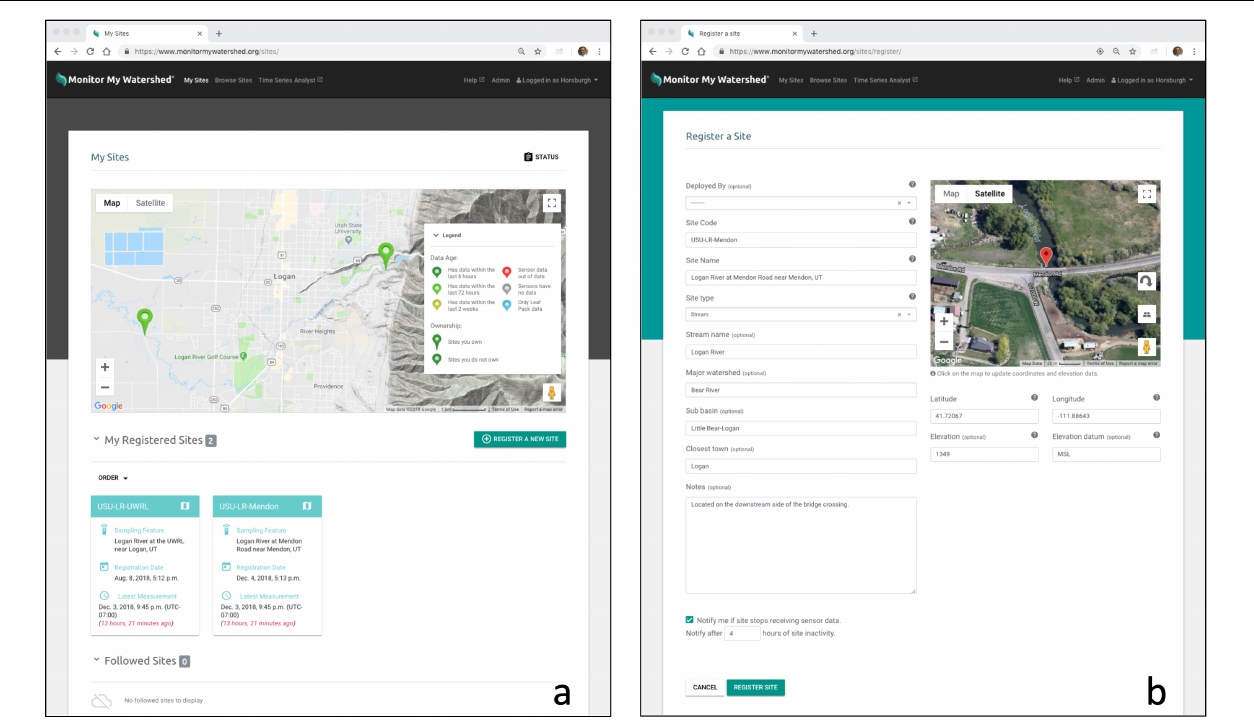
FIGURE 3 | Detailed views of the My Sites page of the Data Sharing Portal. (a) Map view of sites the user has registered and the cards for registered sites. (b) Form for creating a new site or editing an existing site.